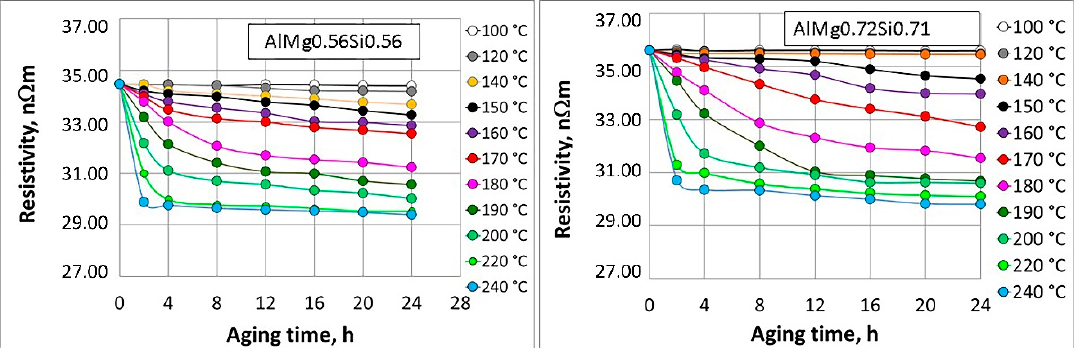
Figure 6. Relationship between resistivity and artificial aging time at different temperatures for the AlMg0.56Si0.56 and AlMg0.72Si0.71 wire rods.